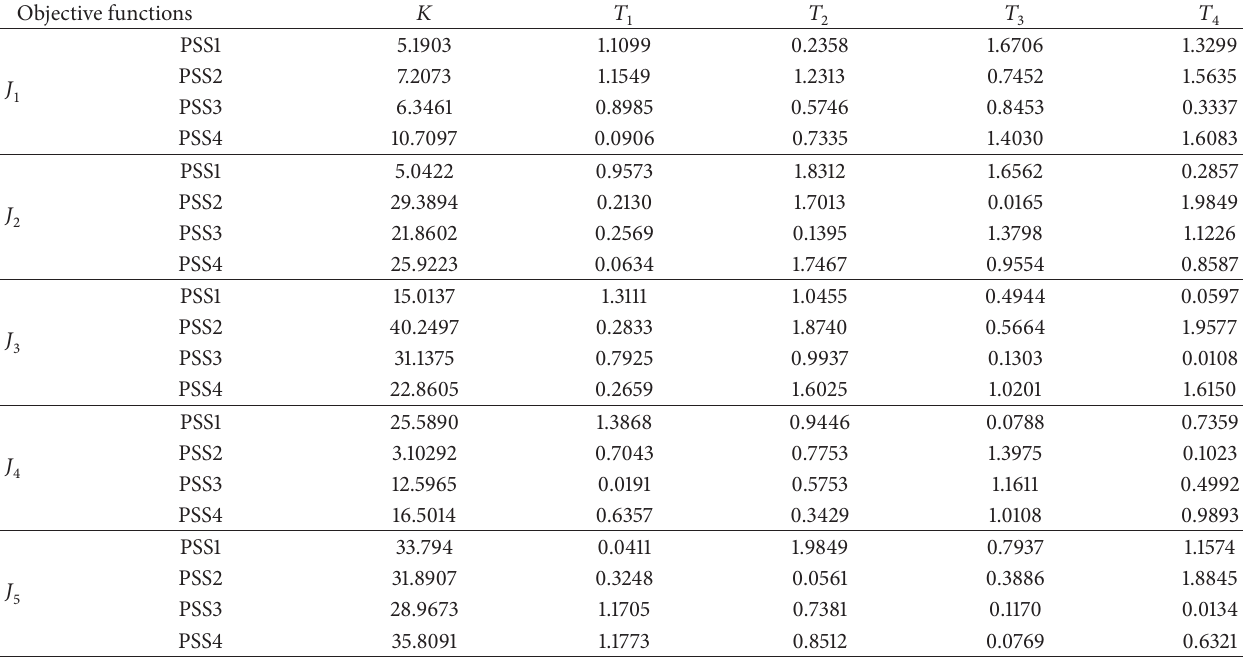
Table 2: Best optimized parameters for each objective function using DSA.